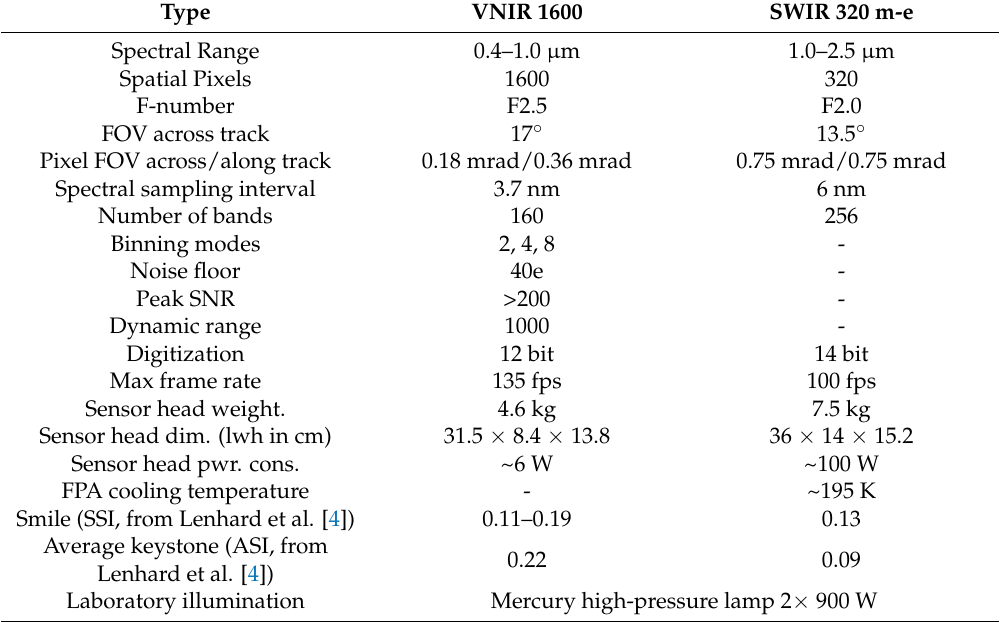
Table 1. Specification of the imaging spectrometer system HySPEX VNIR/SWIR (from manufacturer online resource http://www.hyspex.no/products/disc.php accessed on 14 June 2017).